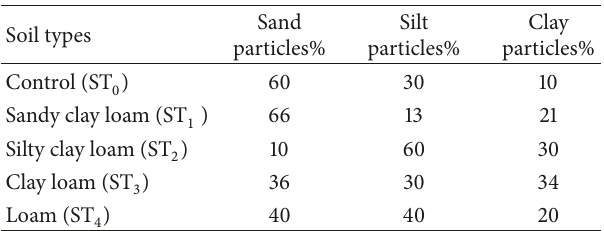
Table 1: Physical characteristics of formulated experimental soil